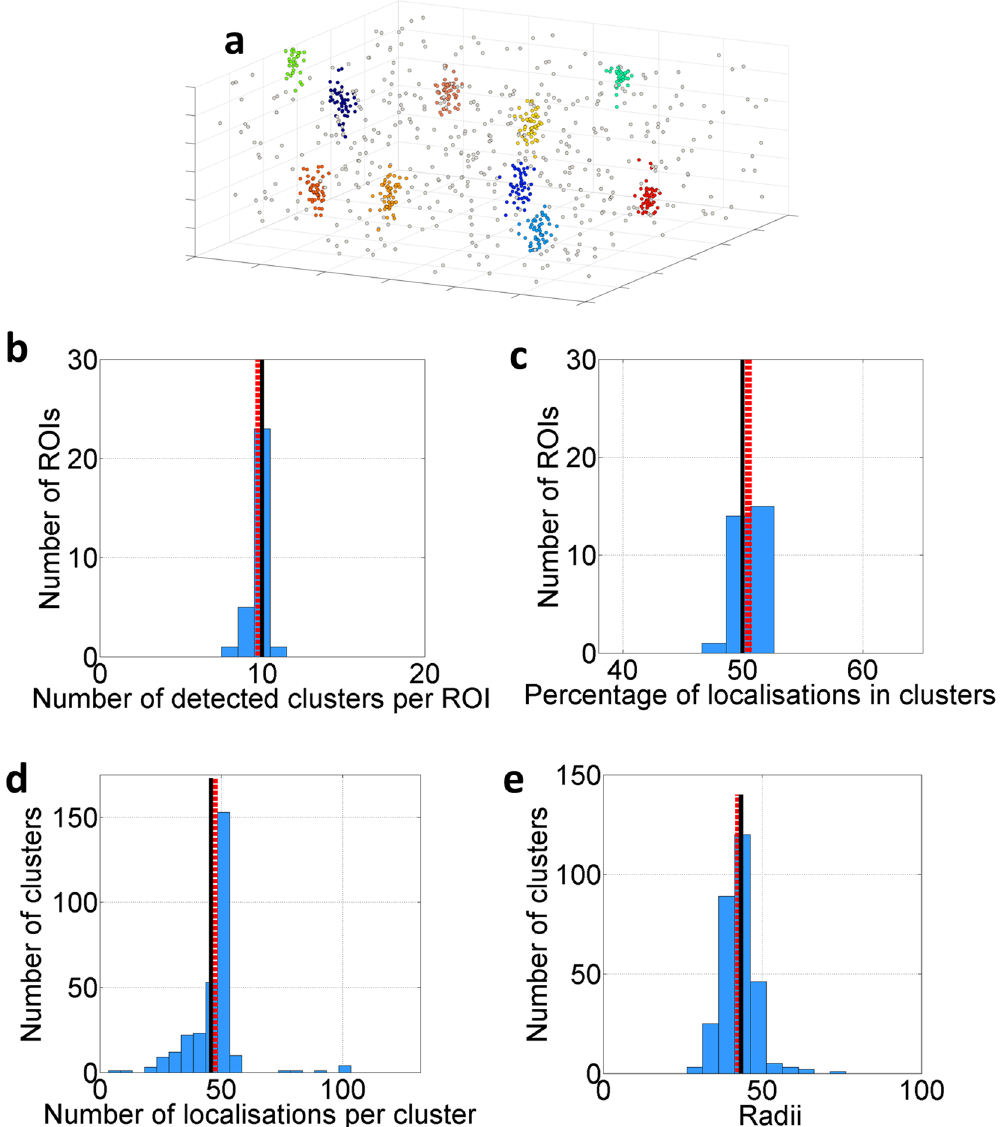
Figure 1. 3D Bayesian cluster analysis of n = 30 simulated data sets in the Standard Condition. ( a ) Representative 3D cluster map with the simulated clusters depicted in colour and non-clustered localisations in grey. ( b ) Number of detected clusters per ROI, ( c ) percentage of localisations detected in clusters, ( d ) number of detected localisations per cluster and ( e ) cluster radii (nm). In each case ( b–e ), the simulated values (black solid line) and mean detected value (red dashed line) are